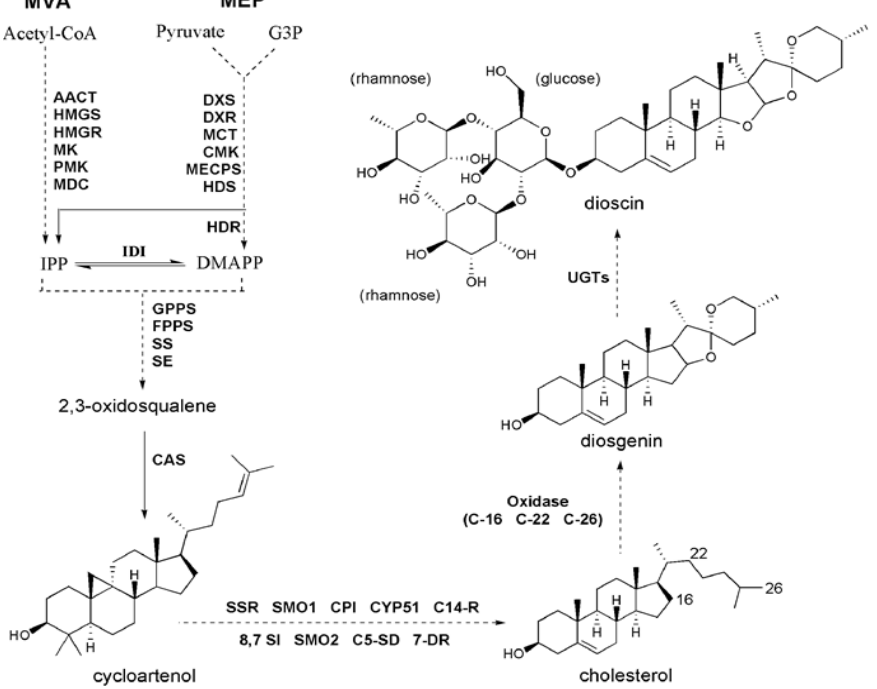
Figure 1. Putative pathway for dioscin biosynthesis in D. zingiberensis . Abbreviations used are: AACT, acetyl CoA acetyltransferase; HMGS, hydroxymethyl glutaryl CoA synthase; HMGR, 3-hydroxy-3- methylglutaryl CoA reductase; MK, mevalonate kinase; PMK, phosphomevalonate kinase; MDC,